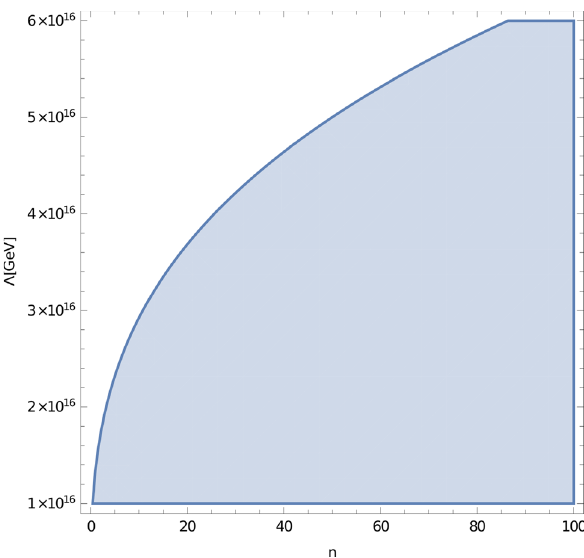
Fig. 4 Excluded parameter space ((cid:14), n ) from DAMA experiment, fix- ing m =